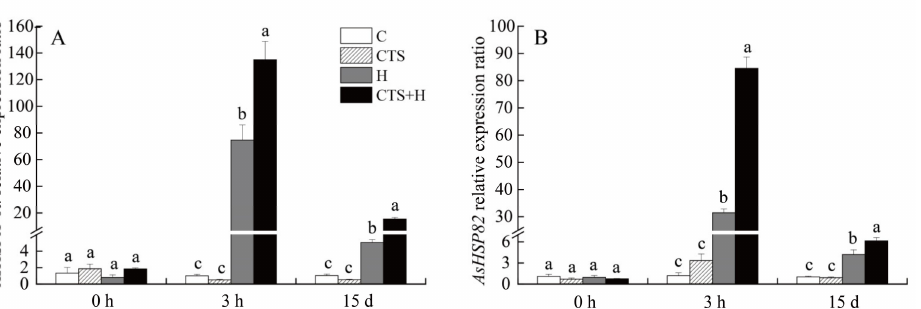
Figure 7. Effect of chitosan on the relative expression levels of ( A ) AsHSFA-6a and ( B ) AsHSP82 under control and heat stress conditions. Vertical bars above columns indicate ± standard error (SE) of means ( n = 4) and different letters above columns indicate significant differences among treatments at one particular time point ( p ≤